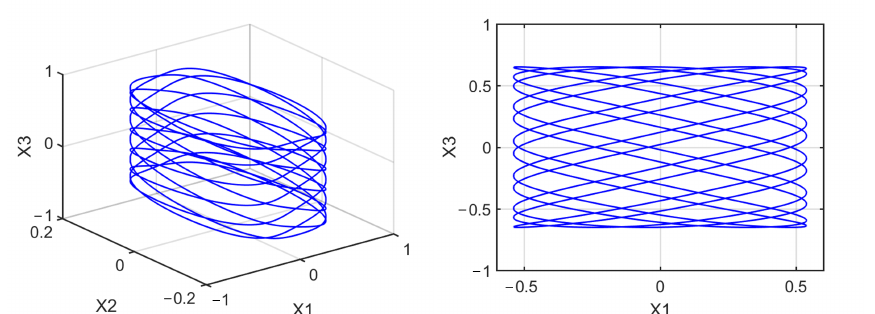
Figure A17. Periodic-9 motion of σ 1 = 1.8987.